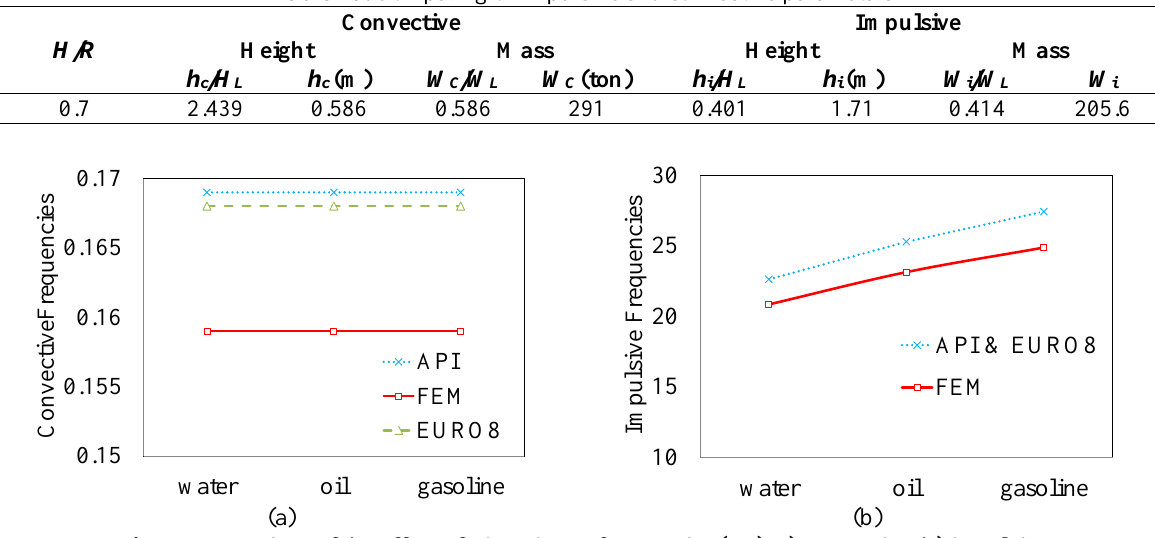
Table 10. Comparing of impulsive and convective parameters